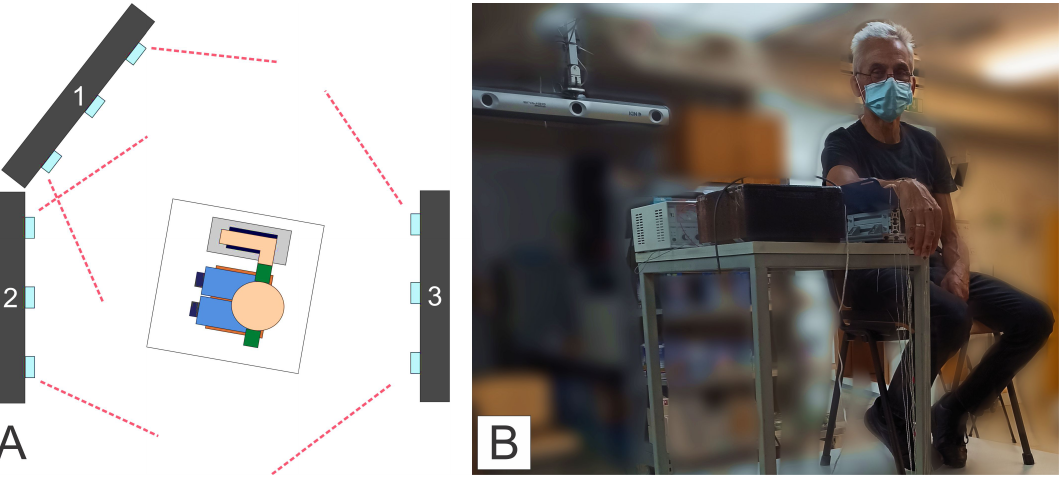
Figure 7. The measurement set up with three cameras—1, 2, 3 ( A ), and a subject within the measure- ment set-up ( B